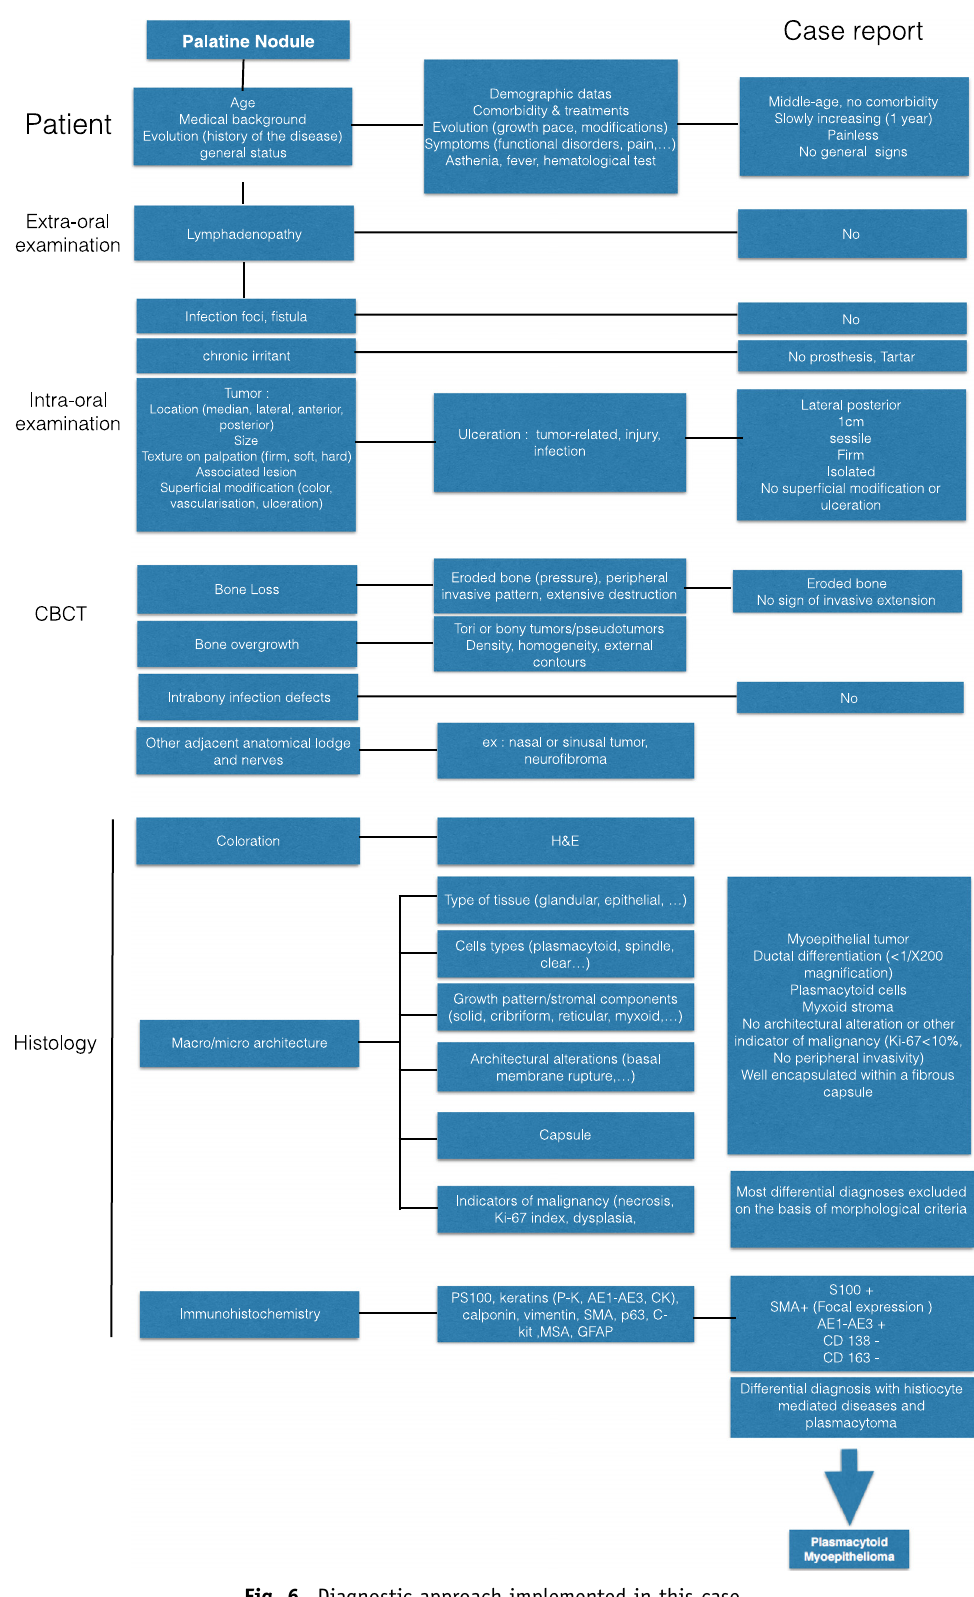
Fig. 6. Diagnostic approach implemented in this